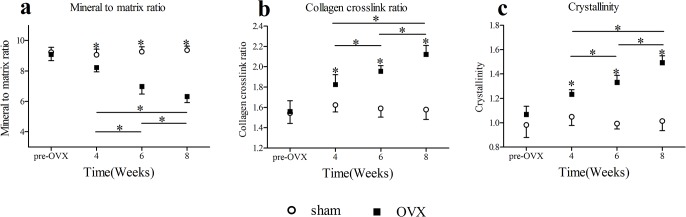
FTIR results(mean ± SD) of cortical bone specimens.Asterisks showed the statistically significant difference between OVX group and sham group at the same time point. 4 week onwards the values of (a)mineral to matrix ratio, (b)collagen crosslink ratio, and (c)crystallinity in OVX group decreased significantly. Transverse lines with asterisks above showed the differences in OVX group among different time points.*p < 0.05.